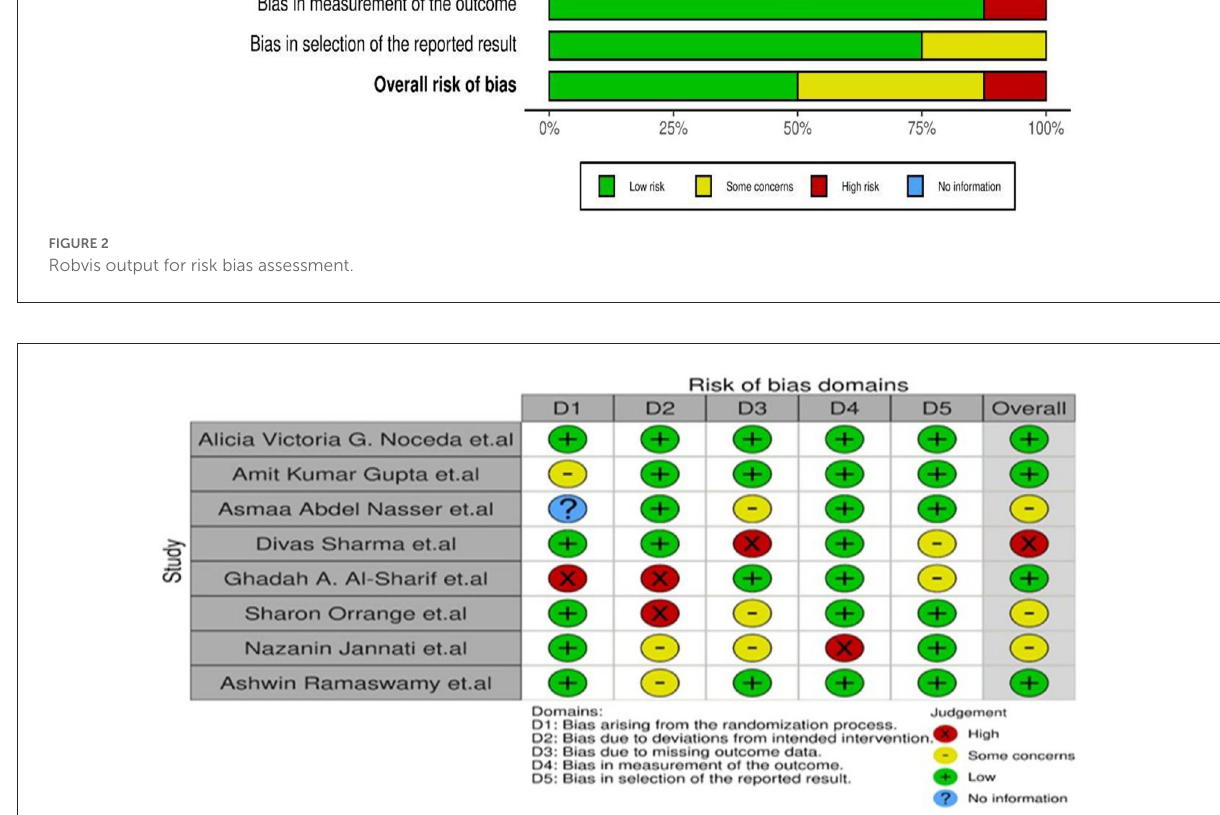
FIGURE3 Weighted output for risk bias